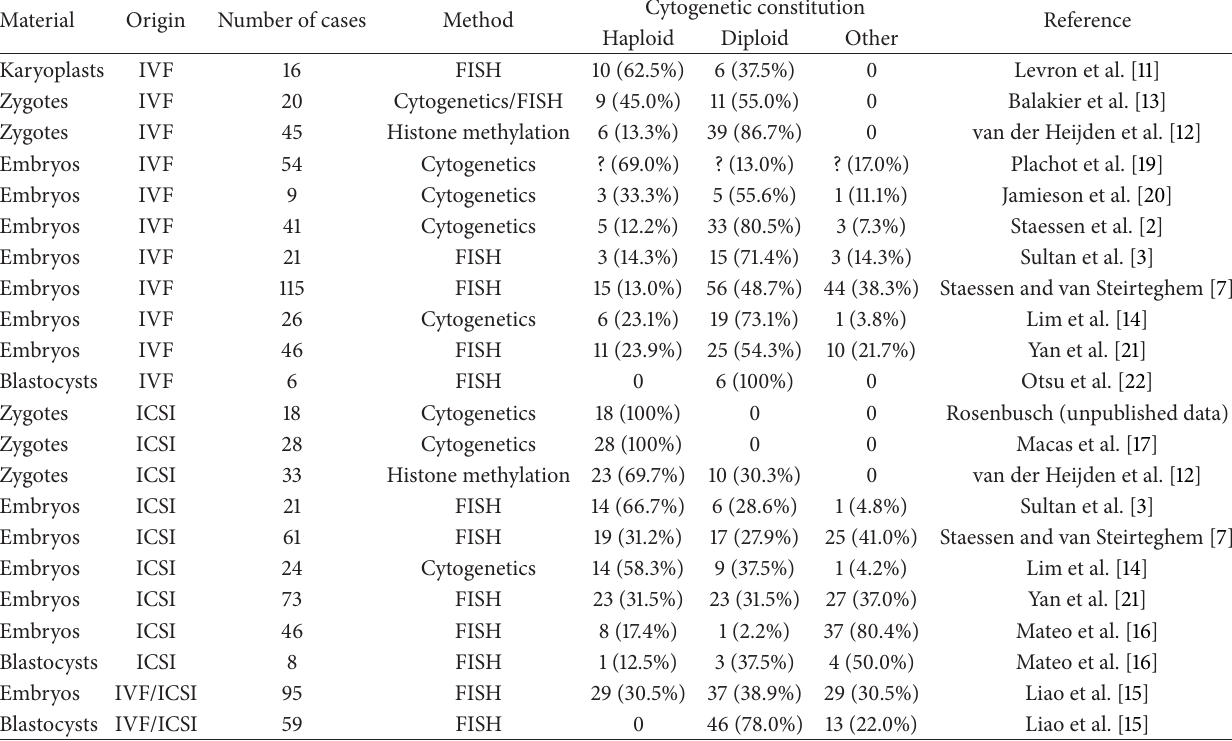
Table 1: The genetic constitution of monopronuclear oocytes and resultant developmental